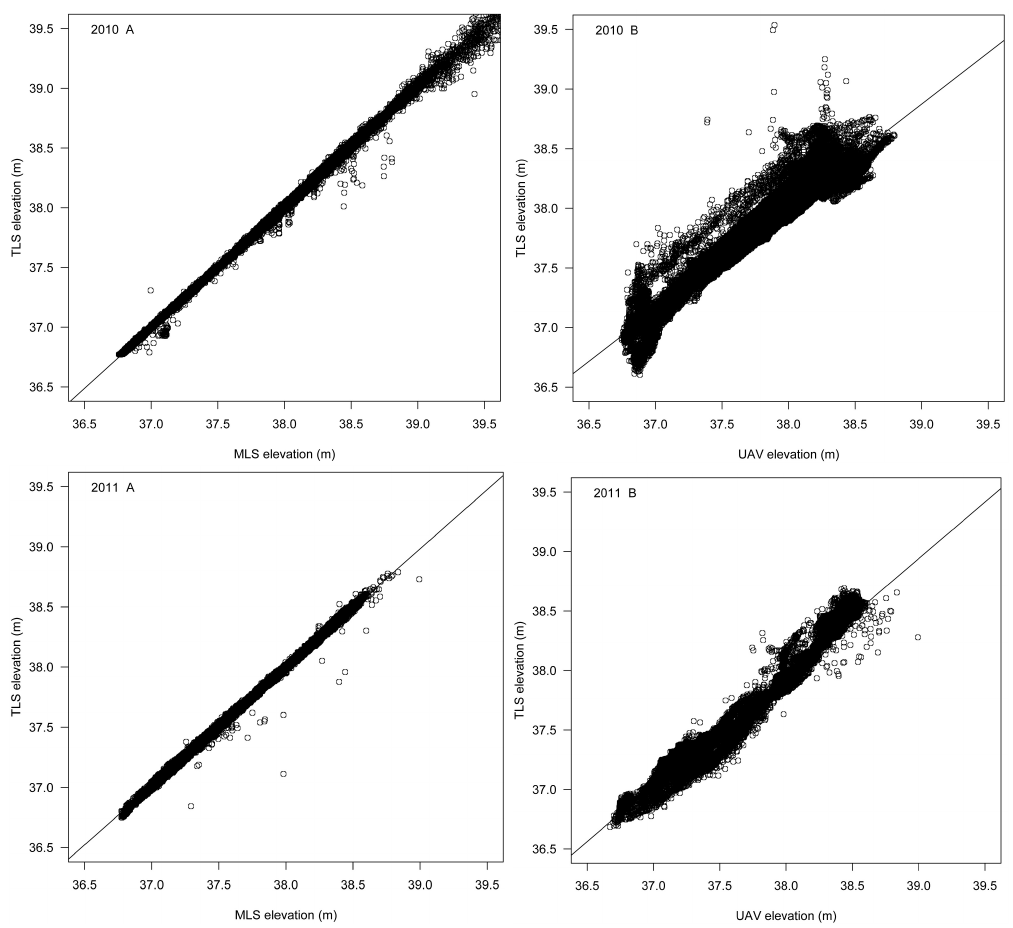
Figure 7. Elevation points of MLS vs. TLS models (A) and UAV photogrammetry vs. TLS (B) of 2010 ( left ) and 2011 ( right